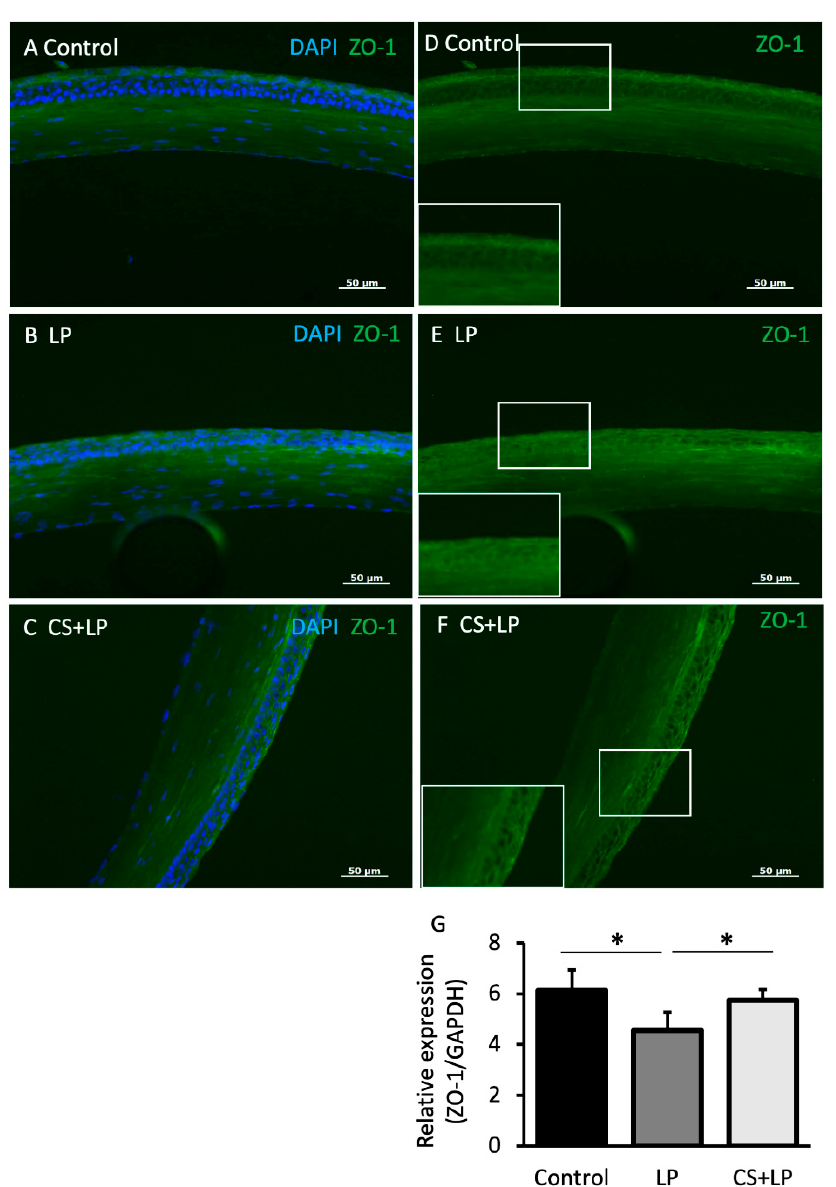
Figure 4. Corneal ZO-1 immunohistochemistry staining and real time RT-PCR corneal ZO-1 mRNA expression comparisons. ( A – C ) Note the marked staining for ZO-1 in the corneal epithelium in Group 1 (no treatment group) and Group 3 (CS + LP group), and the comparably lesser staining in Group 2 (LP group). ( D – F ) Lower left pictograms represent magnified images of the upper corneal square inserts. ( G ) Note the significantly decreased ZO-1 mRNA expression in the LP group compared with the CS + LP group and the no treatment group ( p = 0.011 and p = 0.003, respectively). * represents p < 0.05.